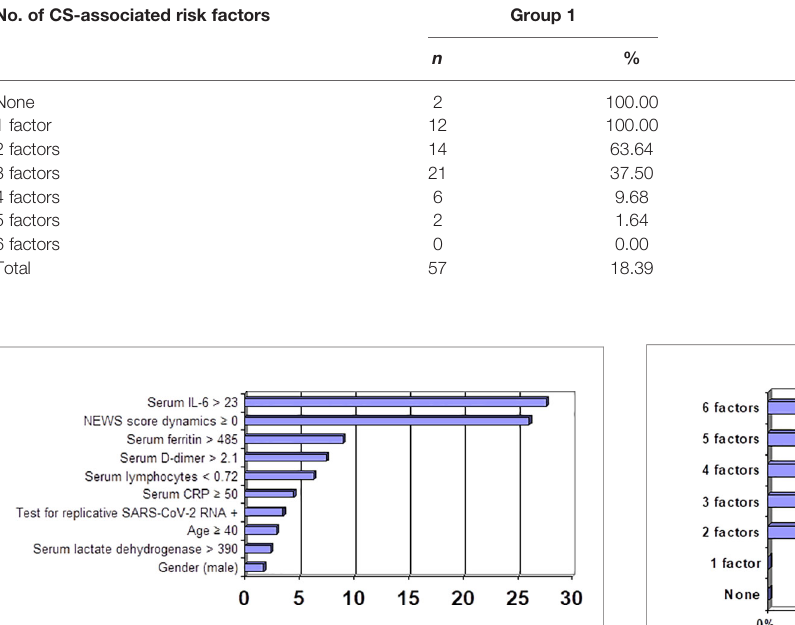
The table shows the threshold values for all parameters that are highlighted as borderline for the risk of developing a cytokine storm.